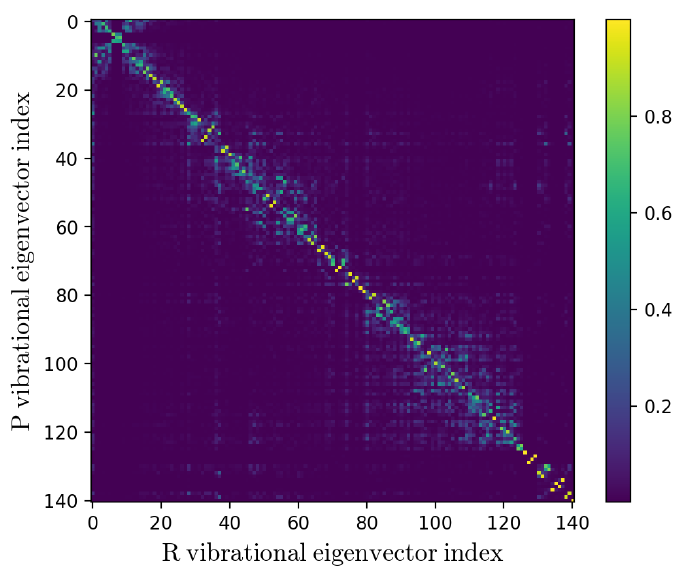
Figure 6. Squared elements of the Duschinsky matrix for the R and P vibrational eigenvectors (i.e., the R and P mass-weighted Hessian